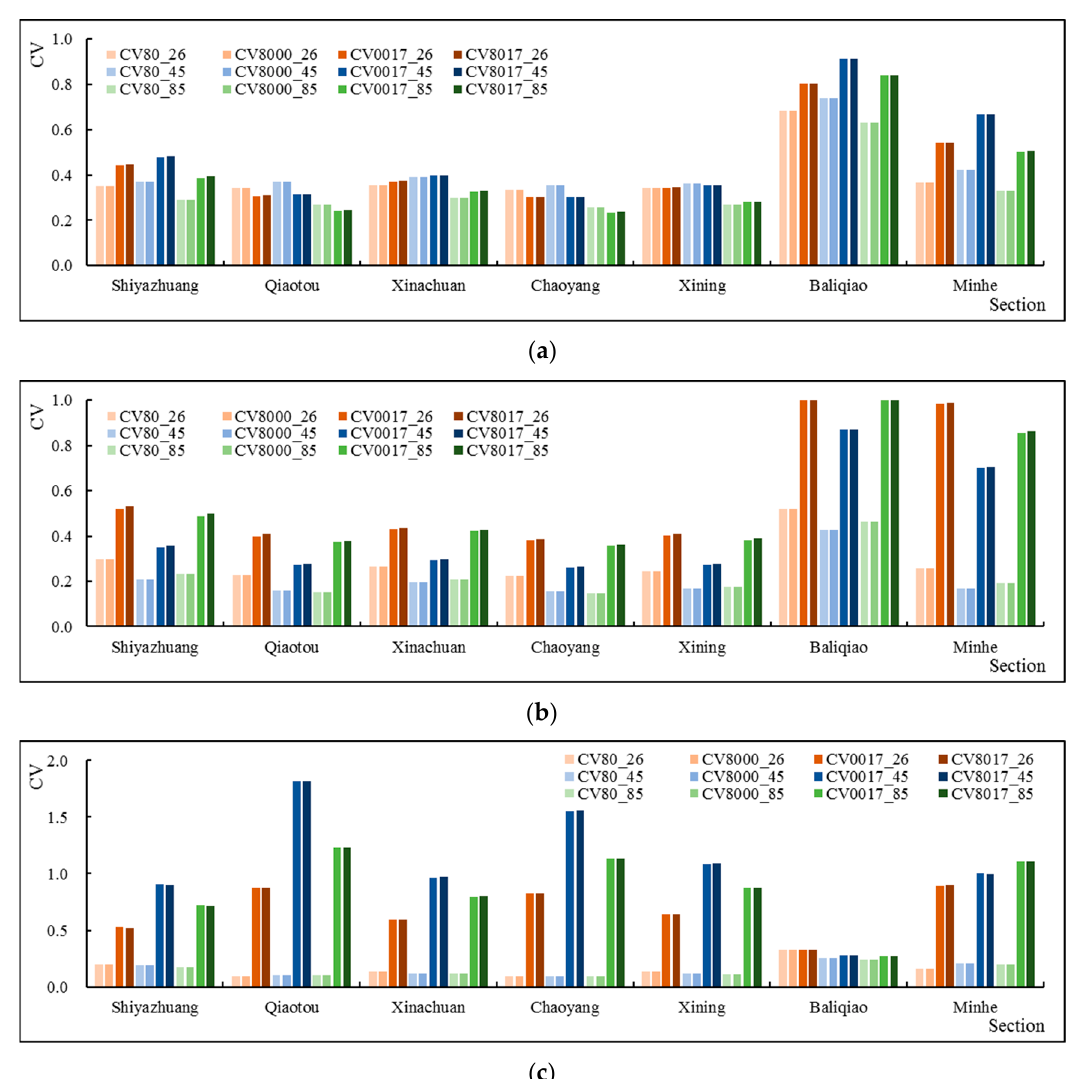
Figure 16. The runoff CV in the wet season ( a ), temperate season ( b ) and dry season ( c ) under different slope ecological restoration scenarios and different climate scenarios .